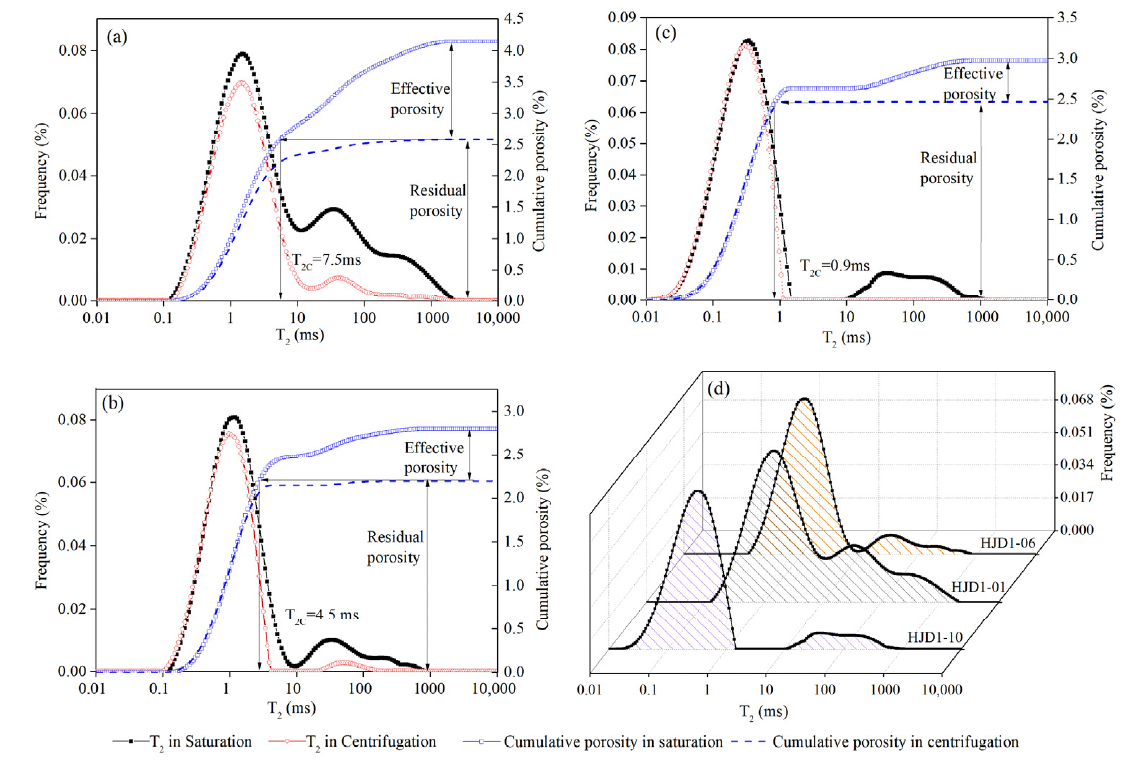
Figure 5. T 2 spectra showing the porosity of different sampling sandstones: ( a ) NMR measurements of HJD1-01 under the water-saturated condition and centrifugal condition; ( b ) NMR measurements of HJD1-06 under the water-saturated condition and centrifugal condition; ( c ) NMR measurements of HJD1-10 under the water-saturated condition and centrifugal condition; ( d ) contrast of T 2 spectra under the water-saturated condition between HJD1-01, HJD1-06, and HJD1-10. T 2 distribution is closely related to the size of the pores. Generally, the longer T 2 , the bigger the pore size. In contrast, the shorter T 2 , the smaller the pore size. The characteristics of the pores in sandstone could be analyzed by the distribution position and the area of the T 2 spectrum [14]. The area of the peaks reflects the number of pores within a certain size; the larger the area, the greater the number of pores. The peak width suggests the distribution of a certain kind of pore, while the number of peaks reflects the continuity of pores at all levels. The two peaks of the T 2 spectra reflect the two main types of pores. Based on the T 2 spectra curve of HJD1-01, HJD1-06, and HJD1-10, micropores correspond to T 2 < 11.09 ms, and macropores correspond to 11.09 ms < T 2 < 1889.65 ms. The micropores peak of the T 2 spectra is the largest, indicating that the micropores are the most developed. The bigger the value of T 2 , the bigger the pore size of the sandstone. The pore size of the micropores from big to small is HJD1-01, HJD1-06, and HJD1-10, The pore size of the macropores from big to small is HJD1-01, HJD1-06, and HJD1-10 as well. The T 2 spectrum morphology of the peak in the saturated state is very close to that after centrifugation (Figure 5c). This means the residual water trapped in the pores cannot be removed by centrifugation, which indicates that the connectivity of the pores is poor. Otherwise, the T 2 spectrum morphology of the peak after centrifugation is very different from the peak in the saturated state; this indicates that the connectivity of pores is good, and the pores are very conducive to gas flow. According to Figure 5a–c, the macropore connectivity in the three testing samples is relatively good, which is significantly better than that of the micropores. Furthermore, there are obvious differences in the connectivity of micropores among the three sandstone samples; the micropores’ connectivity is in the order from good to poor: HJD1-01, HJD1-06,